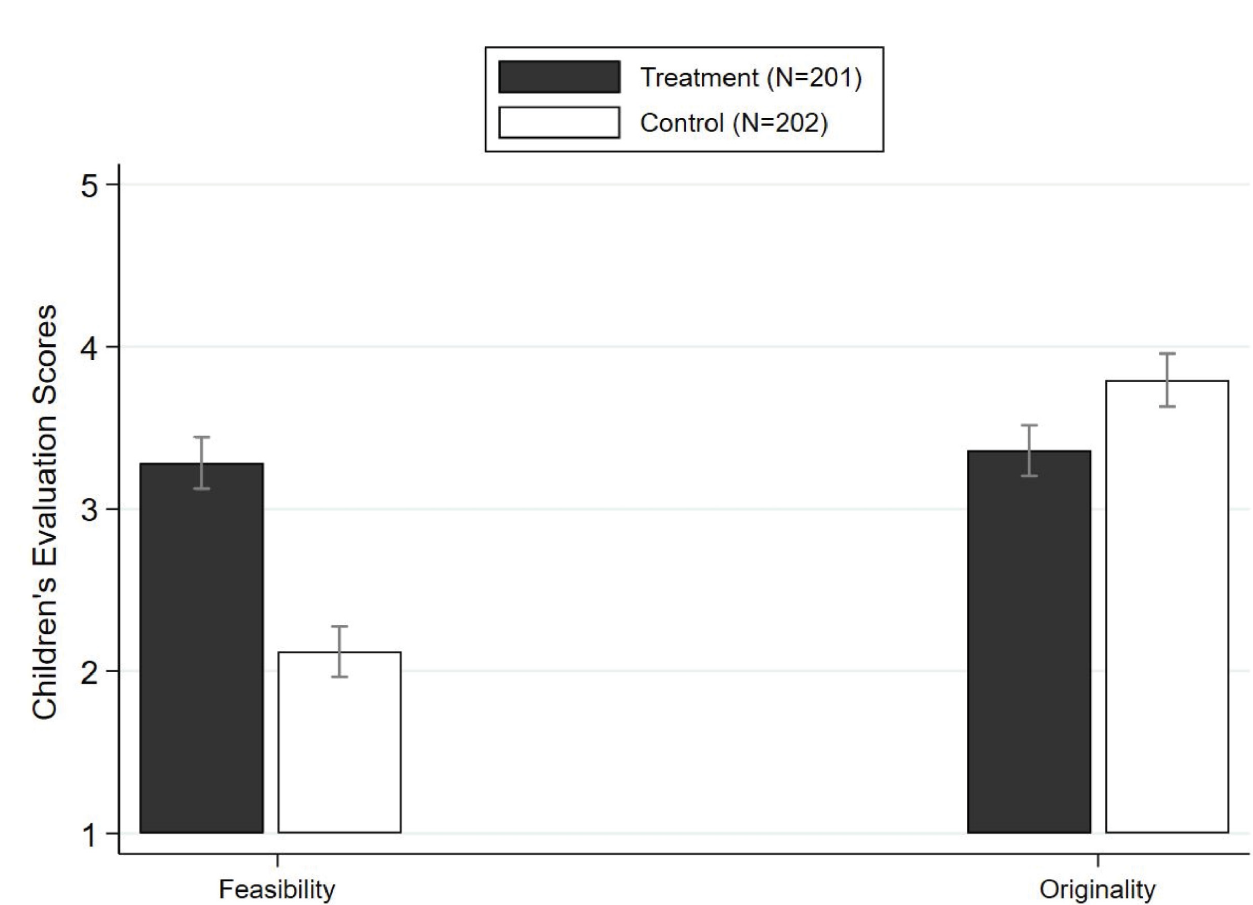
Fig 3. Estimated effect of expected implementation on children’s feasibility and originality ratings. Error bars represent 1 SE. This figure summarizes the intervention’s effect on children’s feasibility and originality ratings. Error bars reflect 95% confidence intervals.